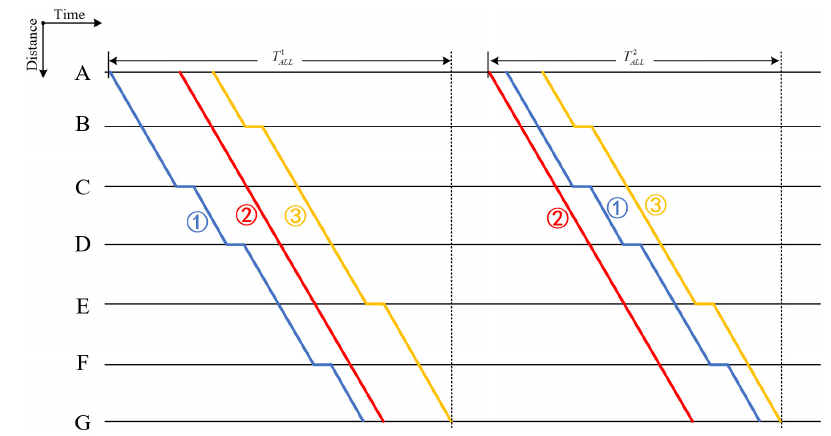
Figure 11. The schematic diagram of the interconnection relationship.